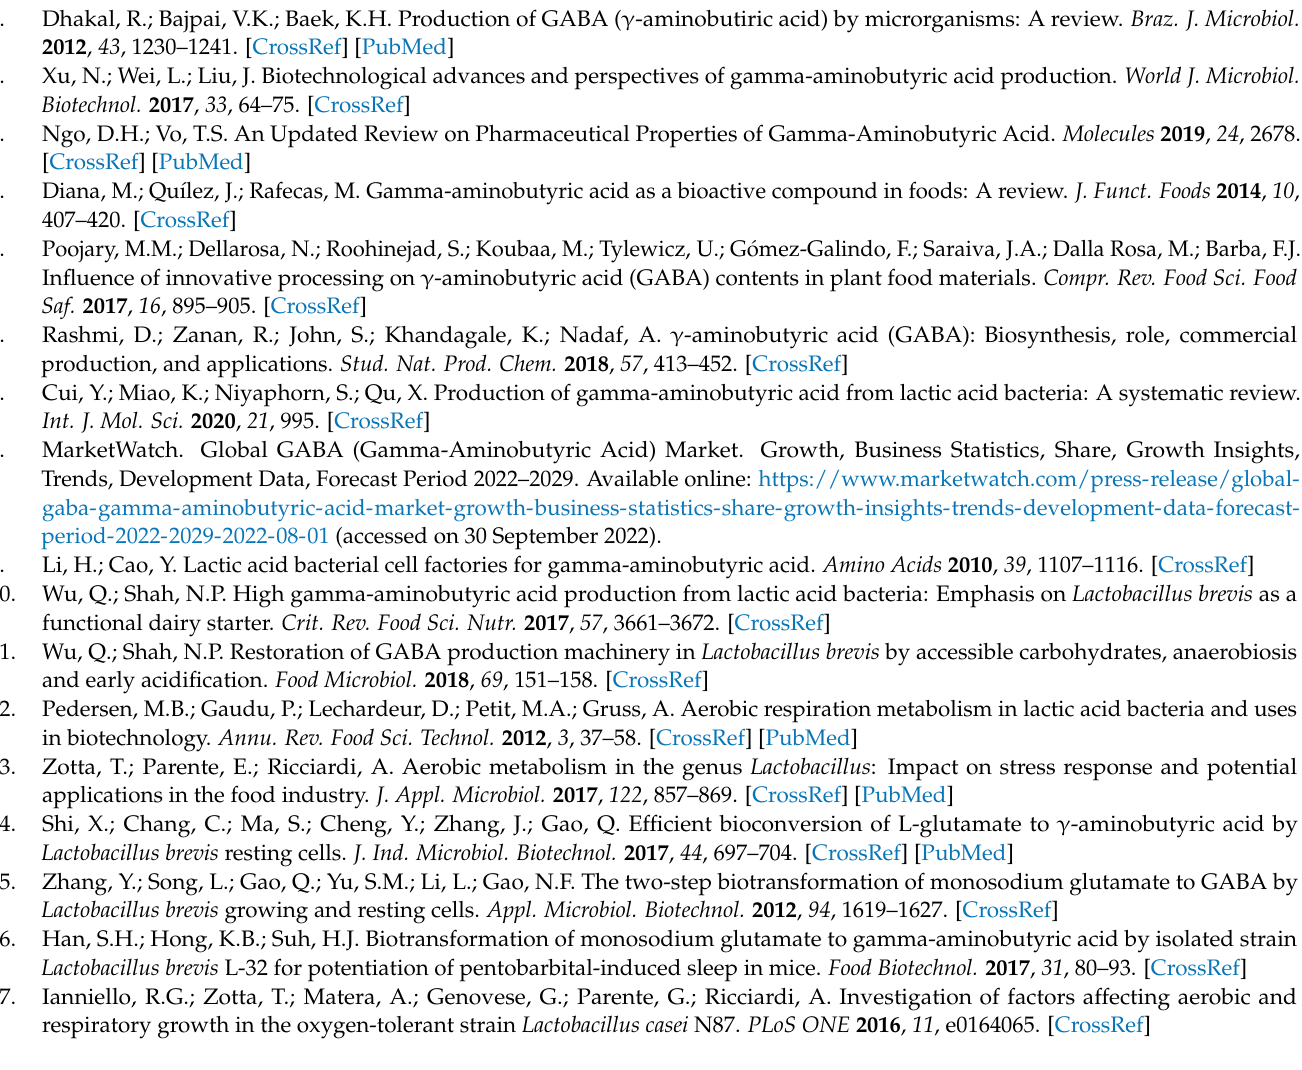
Chromatography (TLC) plate; Figure S3: Correlation between pH values measured in the buffer system inoculated with Levilactobacillus brevis strains grown for 24 h (panel A ; r = 0.728) or 48 h (panel B ; r = 0.285) in unsupplemented MRS or MRS supplemented with 10 g/L MSG (MRS-G); Figure S4: Consumed GLU and total and specific GABA production in five selected strains of Lvb. brevis cultivated under AN, AE, and RS conditions; Figure S5: Changes in pH during the GLU to GABA bioconversion cycles in the buffer system; Figure S6: Correlation between GABA produced (mol/L) and extruded by cells and glutamate taken up by cells (mol/L) and available for GLU/GABA bioconversion; Figure S7: Example of the image analysis of a TLC plate (experiment in the buffer system; Sections 2.4.2 and 2.4.3.) by using NIS-Element BR v2.10 software (Nikon, The